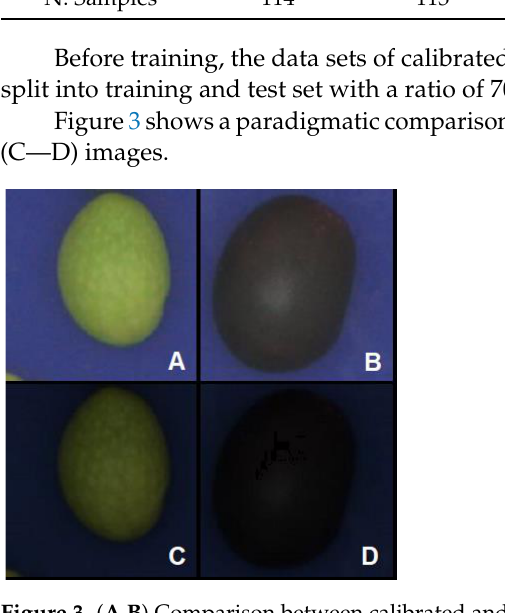
Figure 3. ( A – B ) Comparison between calibrated and ( C - D ) non-calibrated images of olives belong- ing to the class “Top Green” and “Good Black”. to the class “Top Green” and “Good Black”.